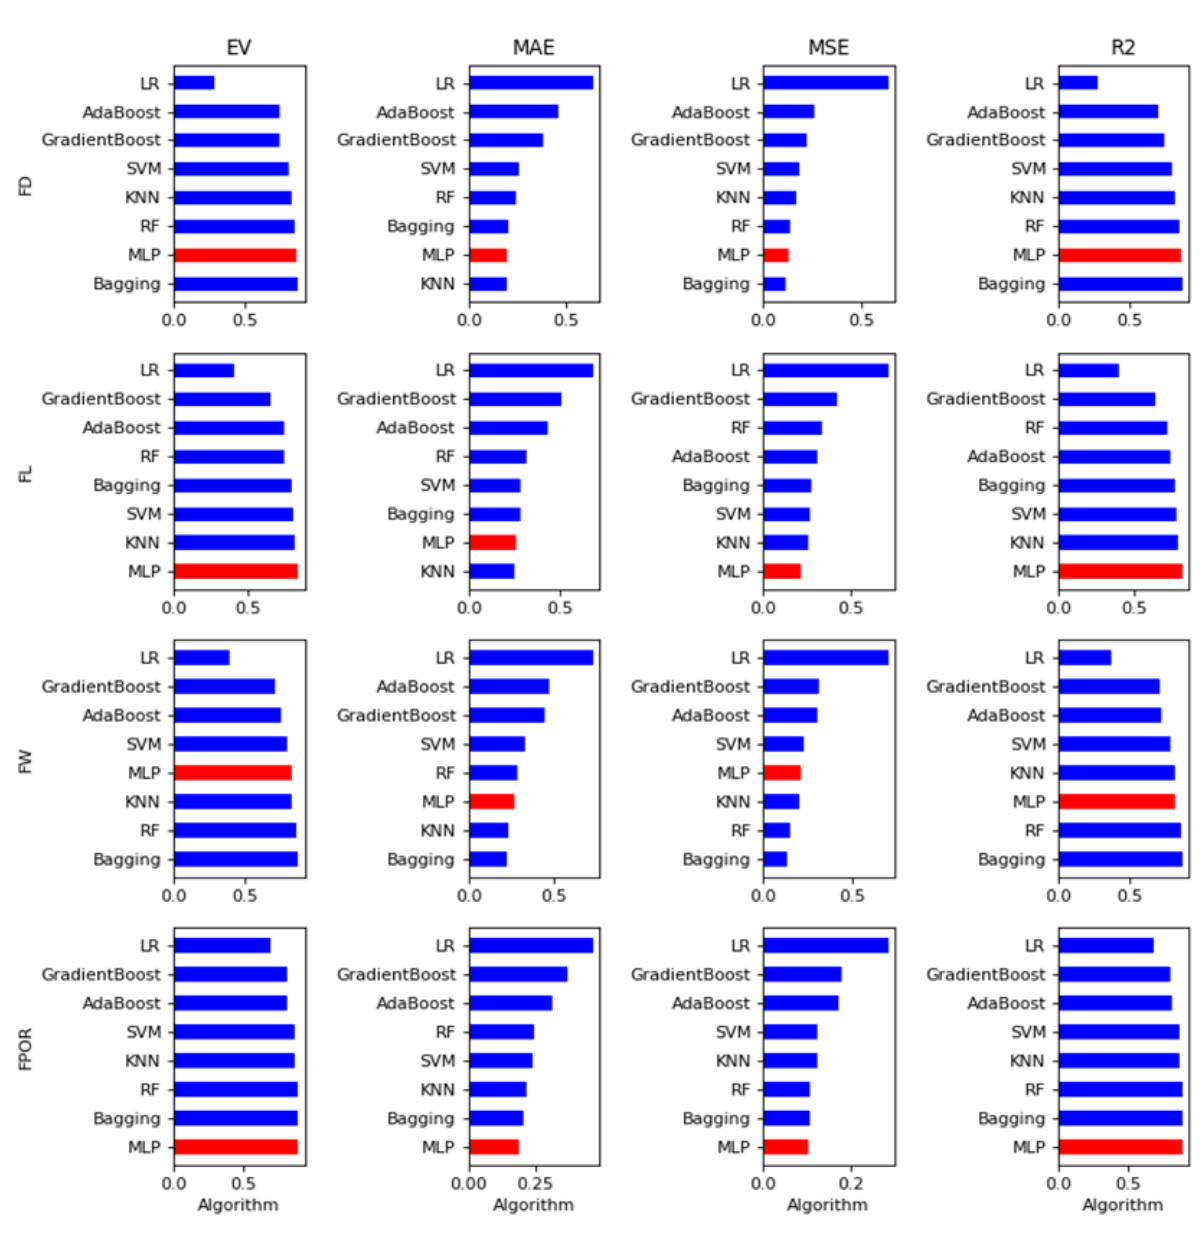
Figure 8. Performance evaluation of various machine‑learning methods for fracture parameter prediction.